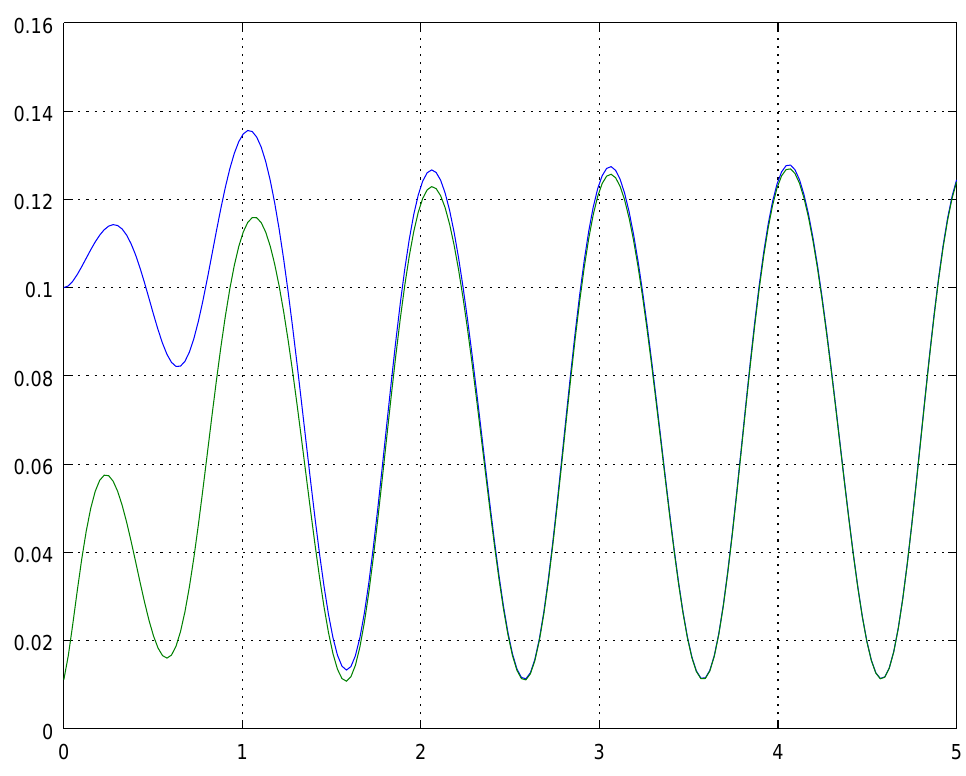
Figure 2. Pr ( X 1 ( t ) = 1 ) under initial conditions (i) and